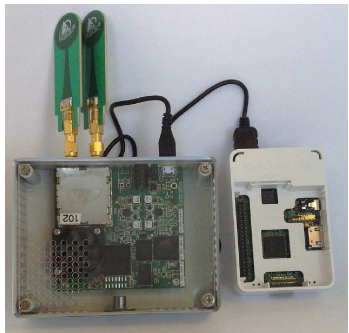
Figure 3. P410 device and associated peripheral